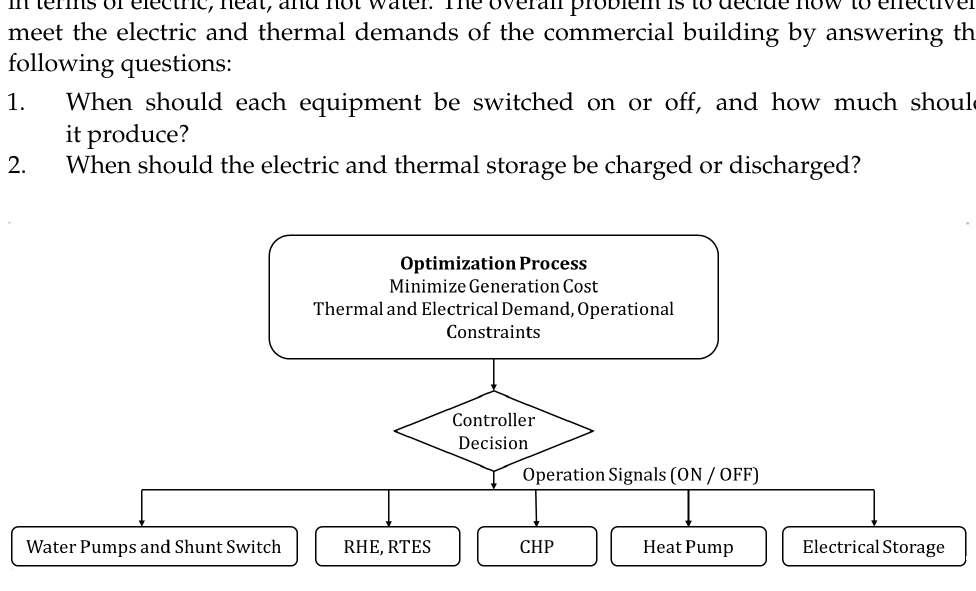
Figure 2. Energy management system